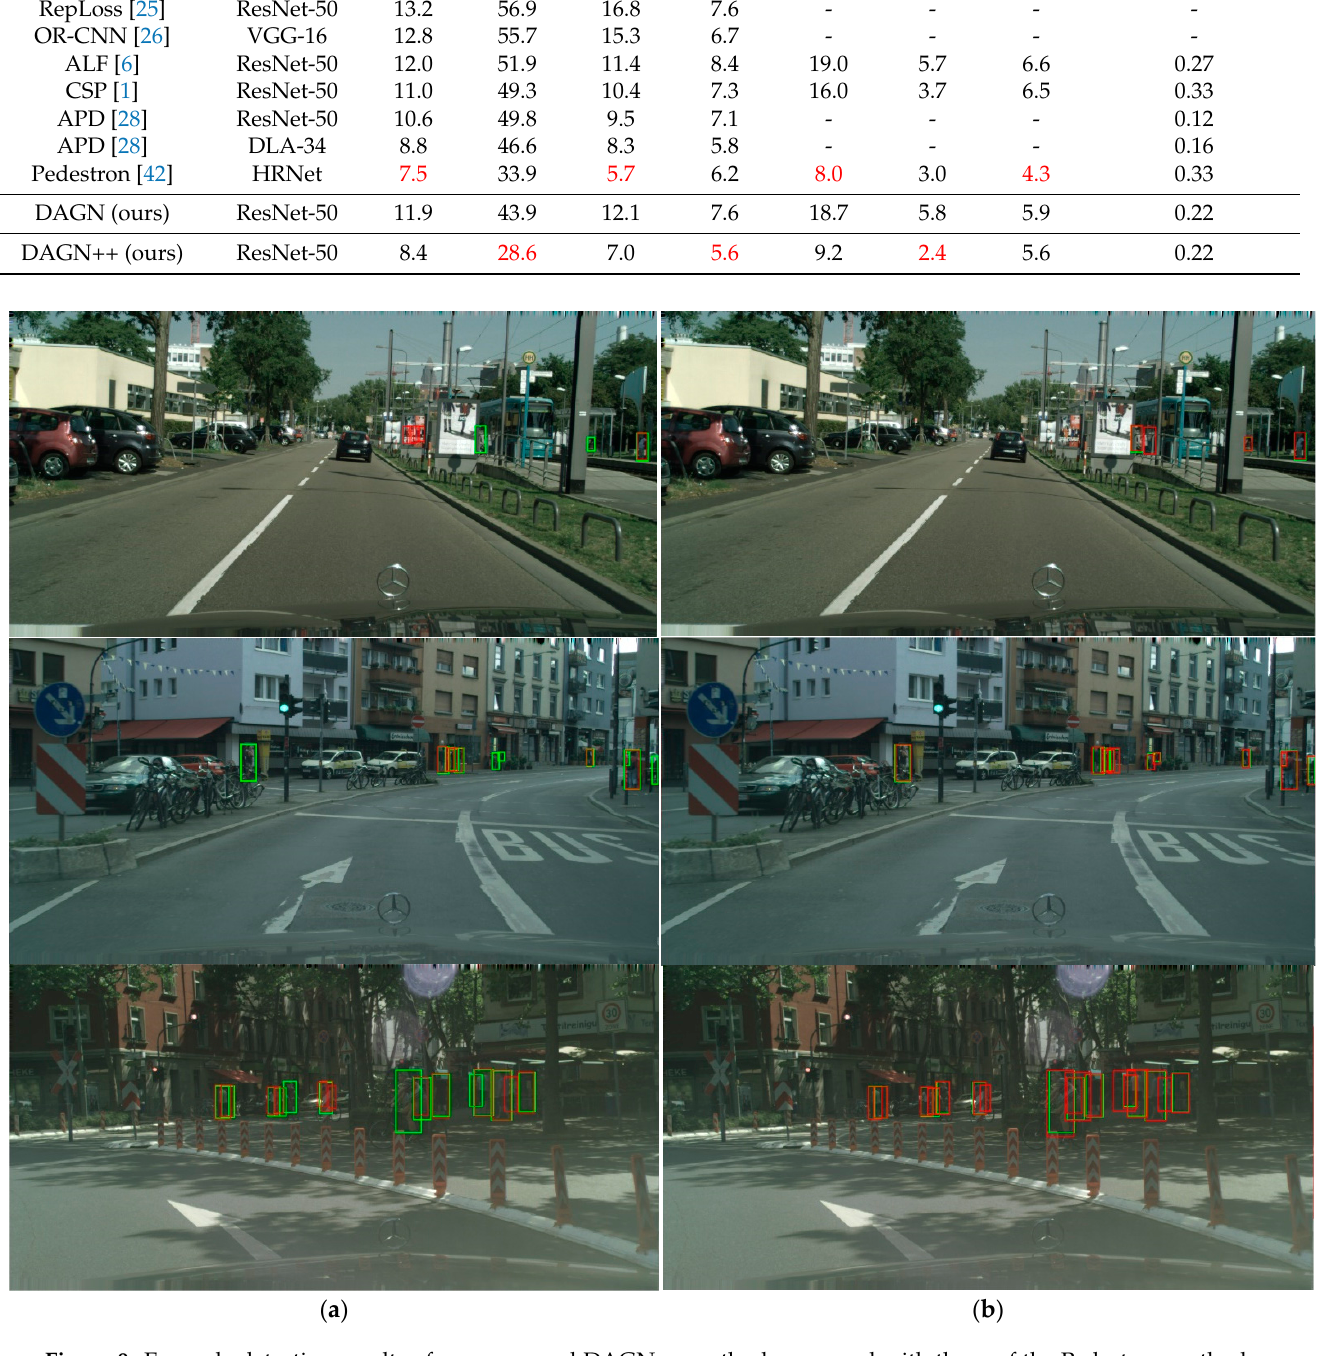
Figure 9. Example detection results of our proposed DAGN++ method compared with those of the Pedestron method on the CityPersons validation set. ( a ) Pedestron [42] and ( b ) DAGN++ (ours). Green boxes, ground truth and red boxes, detection results. We visualized the detection boxes with the confidence score larger than 0.3.